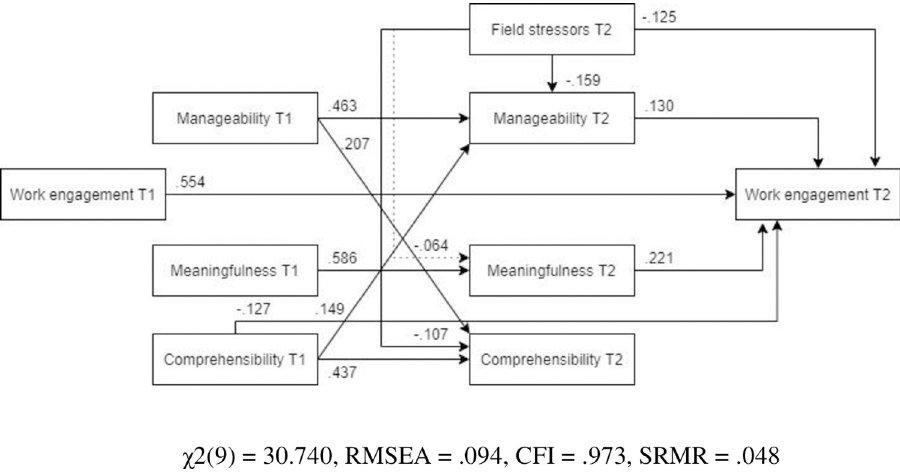
Fig 21. Tested structural equation model of work engagement–females. χ 2(9) = 30.740, RMSEA = .094, CFI = .973, SRMR =